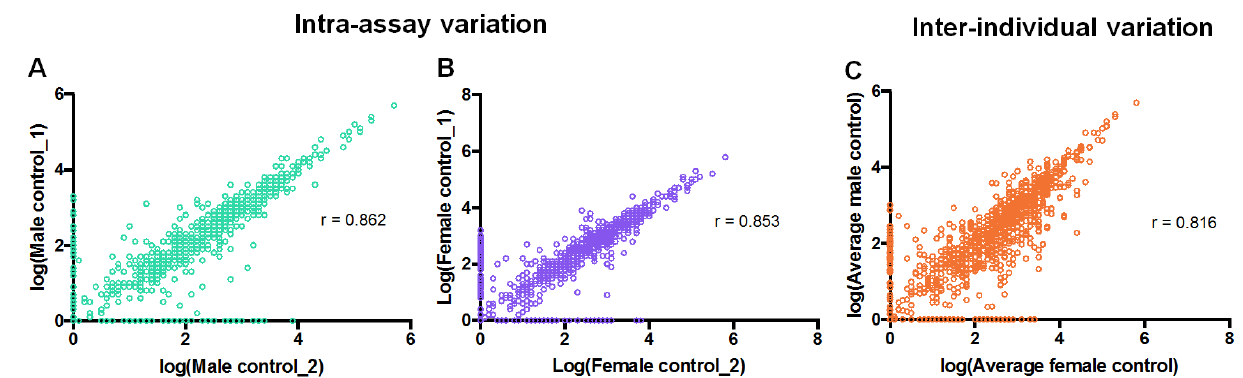
Figure 1. Scatterplot for intra-assay and inter-individual variation. ( A ) Strong intra-assay correlation between the two identical male control samples (aliquot 1 vs. aliquot 2) that were assayed in a blinded fashion (P<0.001). Similarly, ( B ) shows strong correlation between the two identical female control samples (P<0.001). ( C ) Strong correlation between the average value of the two male control samples and that of the two female control samples (P<0.001). Pearson correlation coefficient (r) was used for analysis.